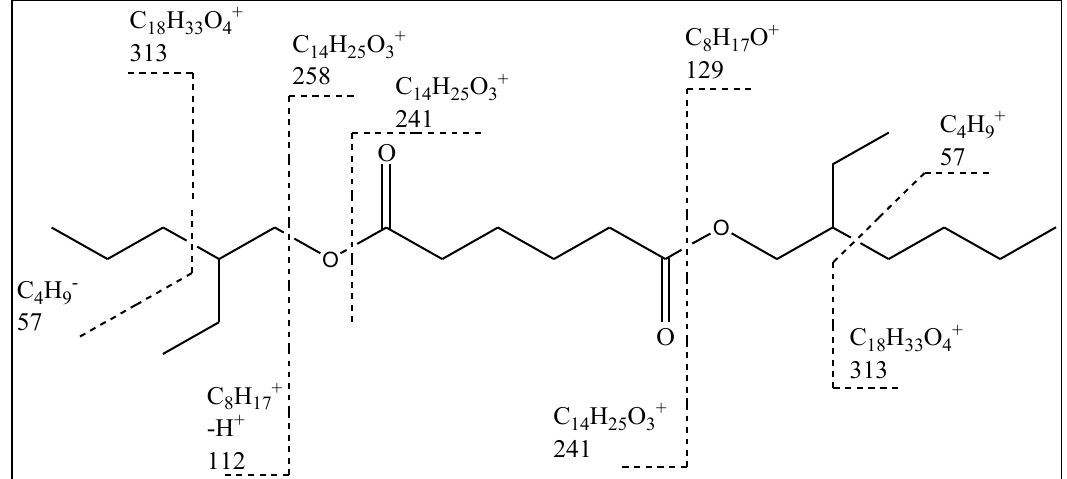
Fig. 2. Schematic representation of mass fragmentation pattern for spectral data of n -hexanedioic acid, bis-(2-ethylhexyl) ester (XXV) Mass fragmentation of n -hexanedioic acid, bis-(2- ethylhexyl) ester (XXV) is shown in Figure 2.